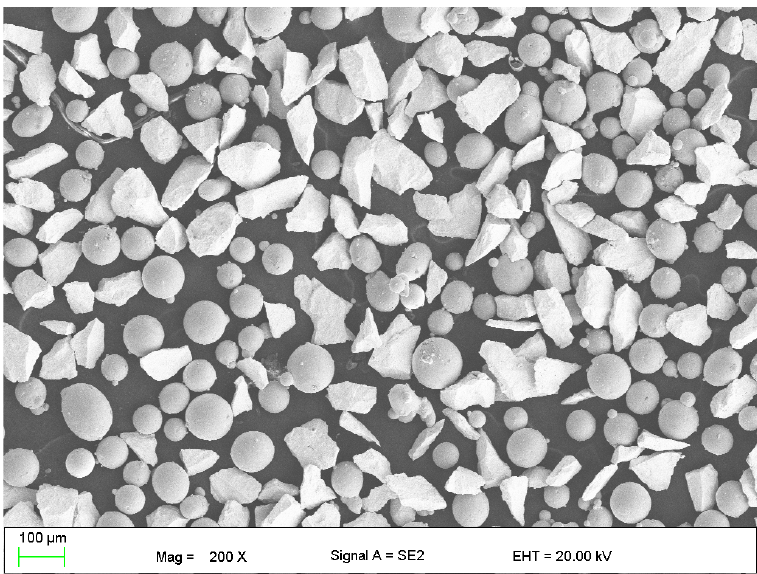
Figure 2. Morphology of the experimental composite powder NiCrBSi/WC + W 2 C; mixture of irregular WC particles and spherical metallic Ni-based particles, Table 1.